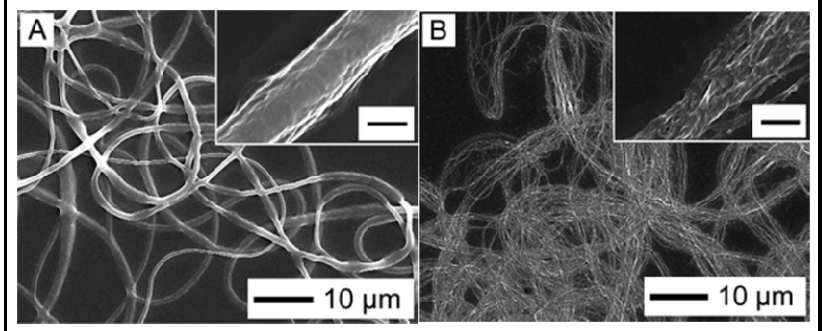
Figure 29. Schemes showing ( left ) the coaxial electrospinning setup for P3HT electrospinning and ( right ) the elongation of P3HT domains and formation of continuous P3HT fibrils from the elongation of P3HT domains in highly concentrated PCL solutions. Reprinted with permission from [128]. Copyright 2009 Royal Society of